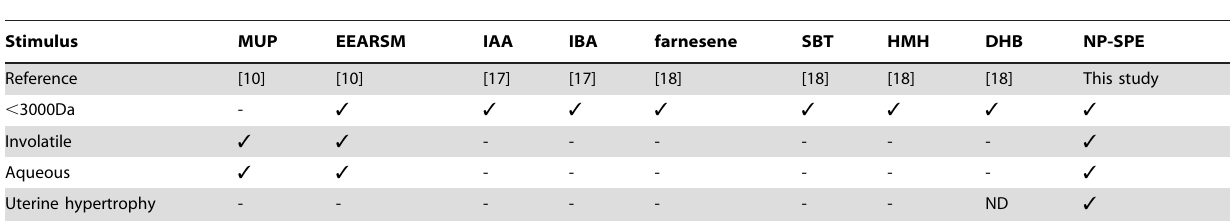
Table 1. Summary of biochemical properties of stimuli.